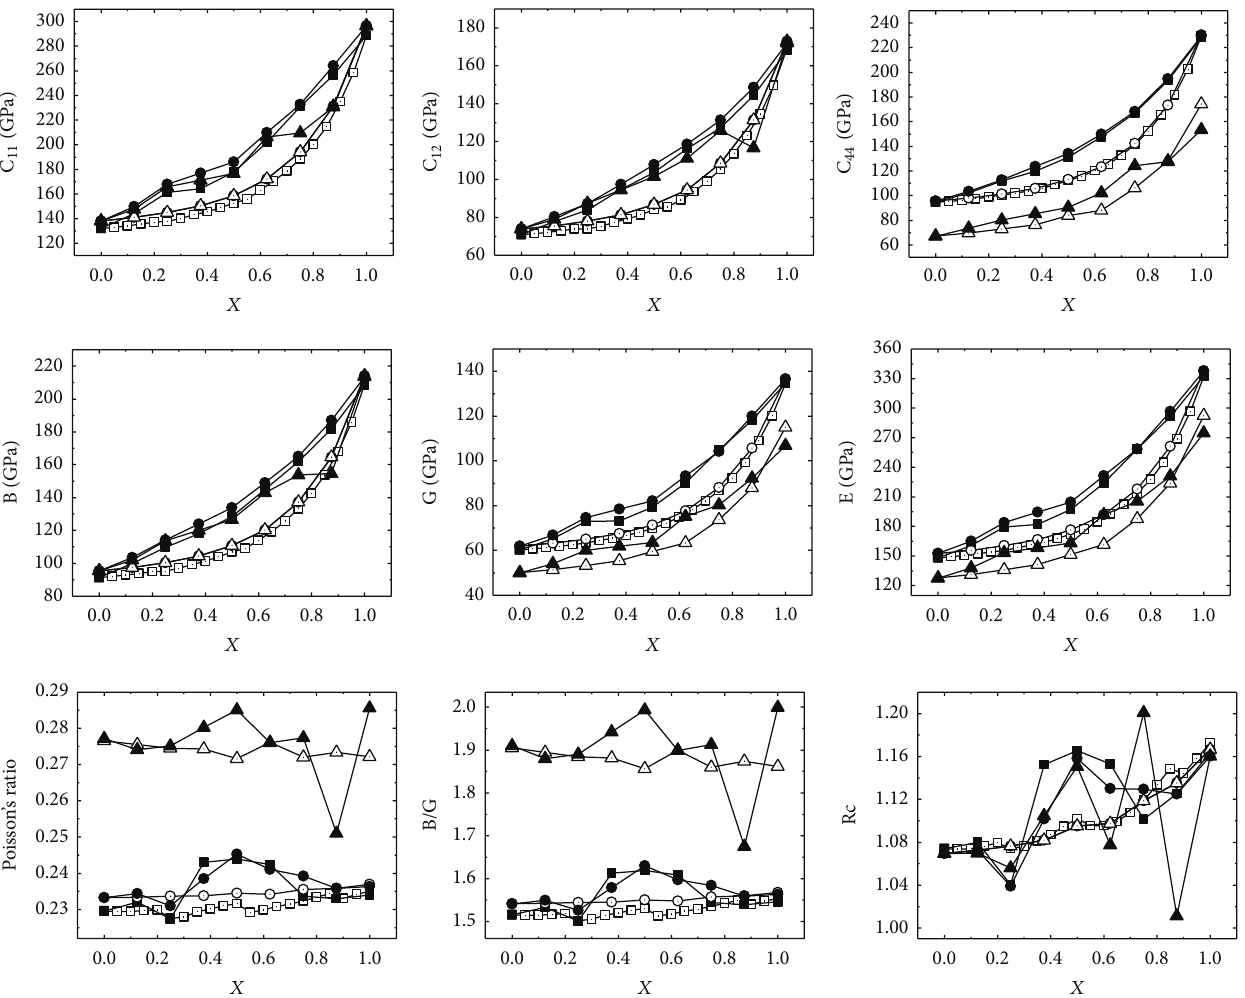
Figure 2: Composition dependence of all studied elastic properties in the zinc-blende (ZB) structure. Each graph presents one property calculated using all the methods. Filled points represent the supercell (SC) alloy simulation while empty points represent the alchemical mixing (AM). Squares: finite difference method, circles: clamped case of DFPT, and triangles: relaxed case of